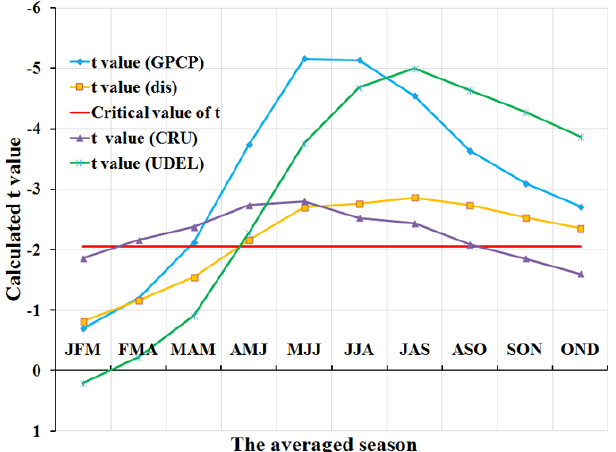
Fig. 10. 95% significance test of the correlation between SST anomalies in Niño 3.4 region and the GPCP, CRU, UDEL and dis-